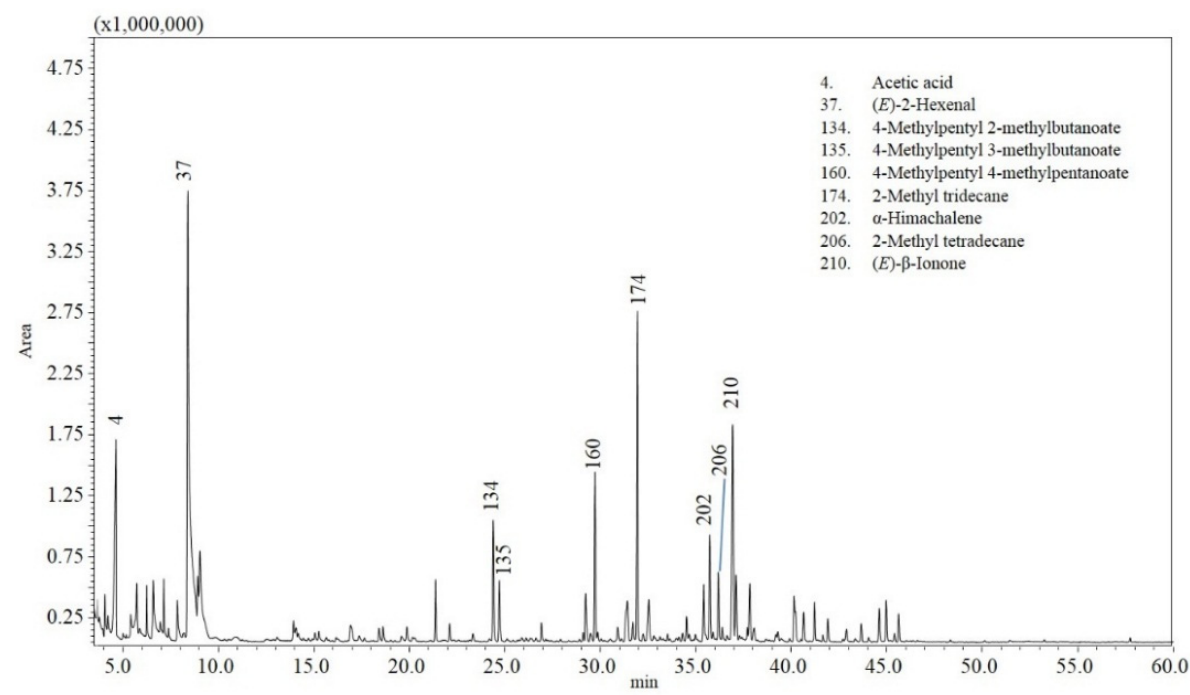
Figure 2. GC ‐ MS analysis of the volatile profile for sample 14 ( C. annuum —Calabrian pepper).